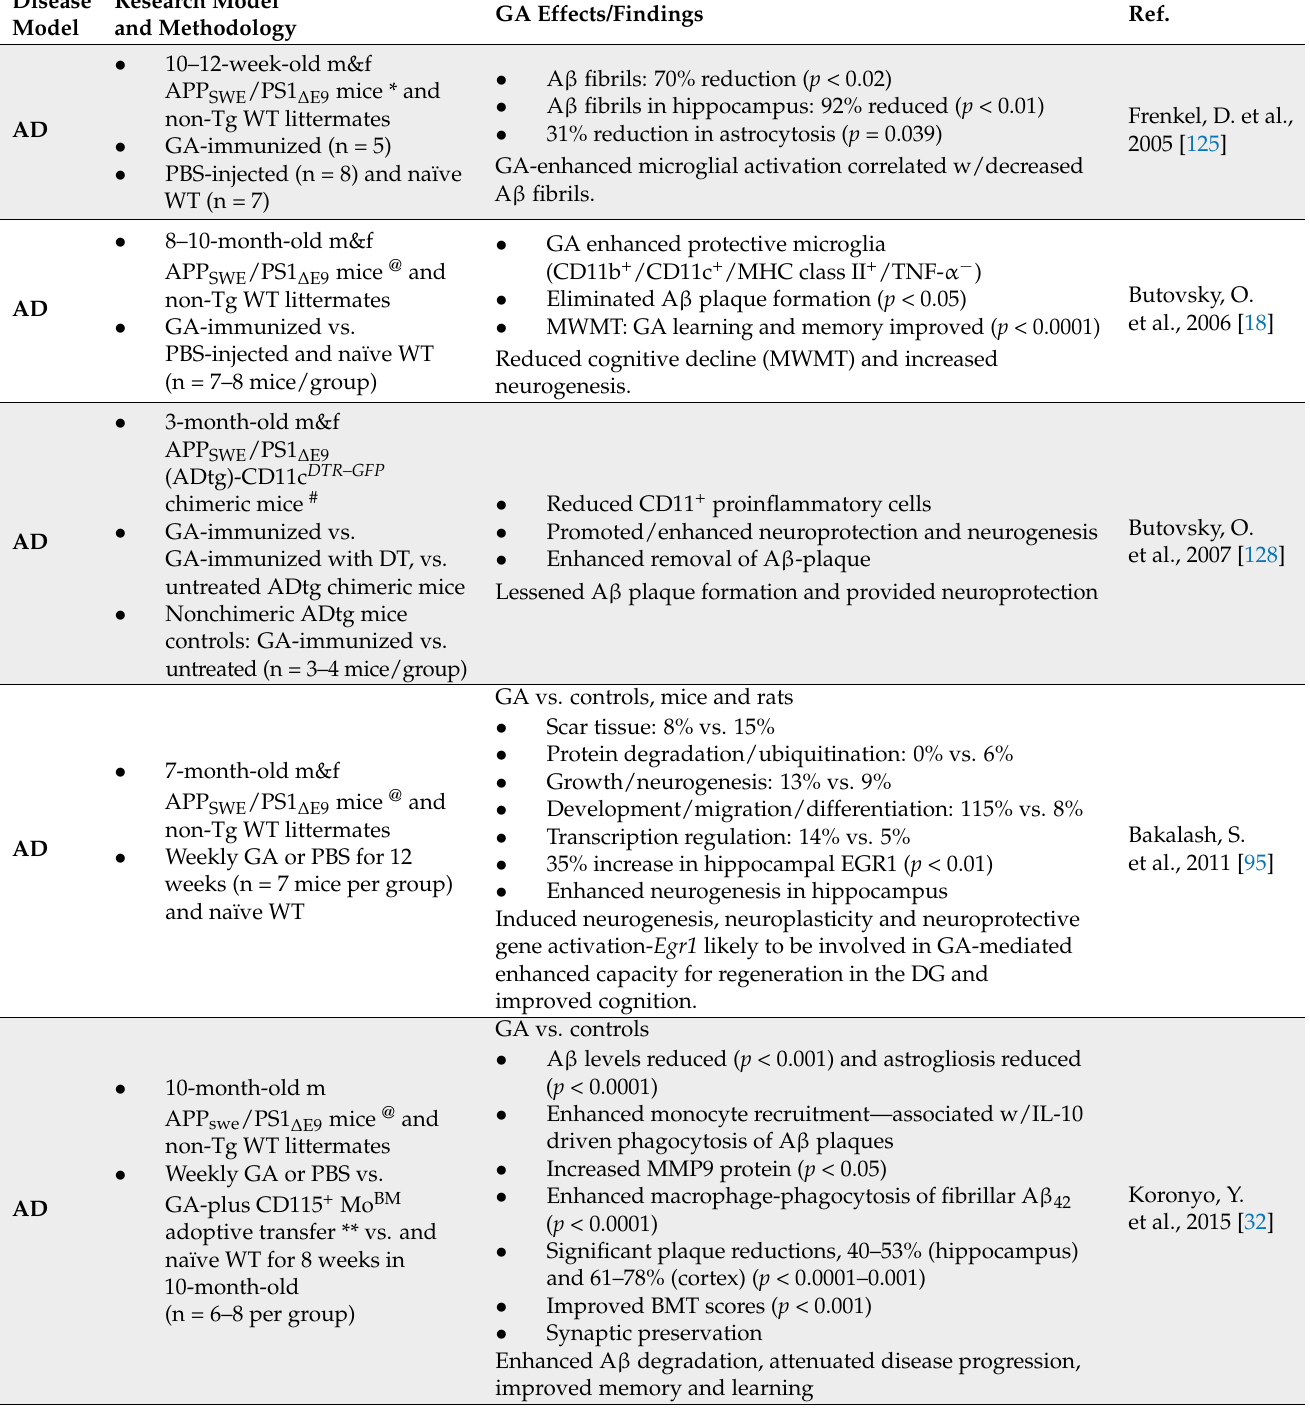
Table 6. Animal Studies Examining Alternative Uses of Glatiramer Acetate in Alzheimer’s